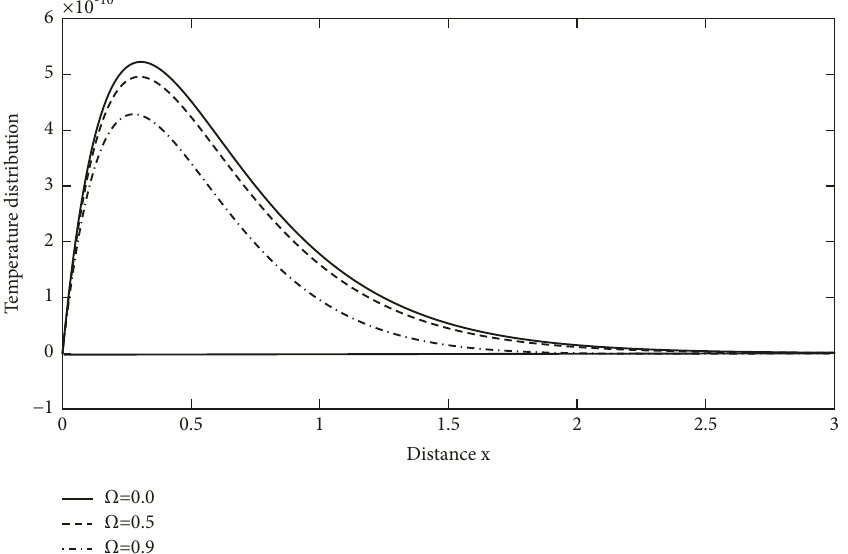
Figure 5: Effect of angular velocity on temperature